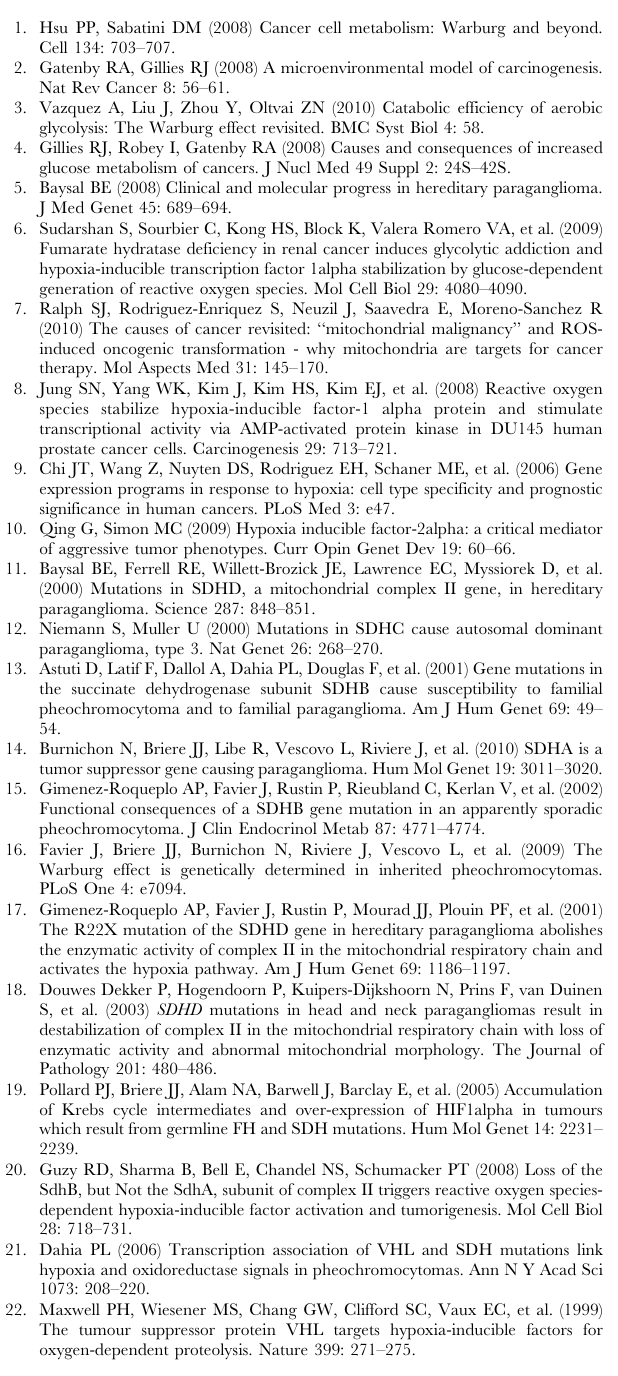
Table S2 Peptide identification summary. Table listing the characteristics of detected peptides for each spot, including their sequences and database search